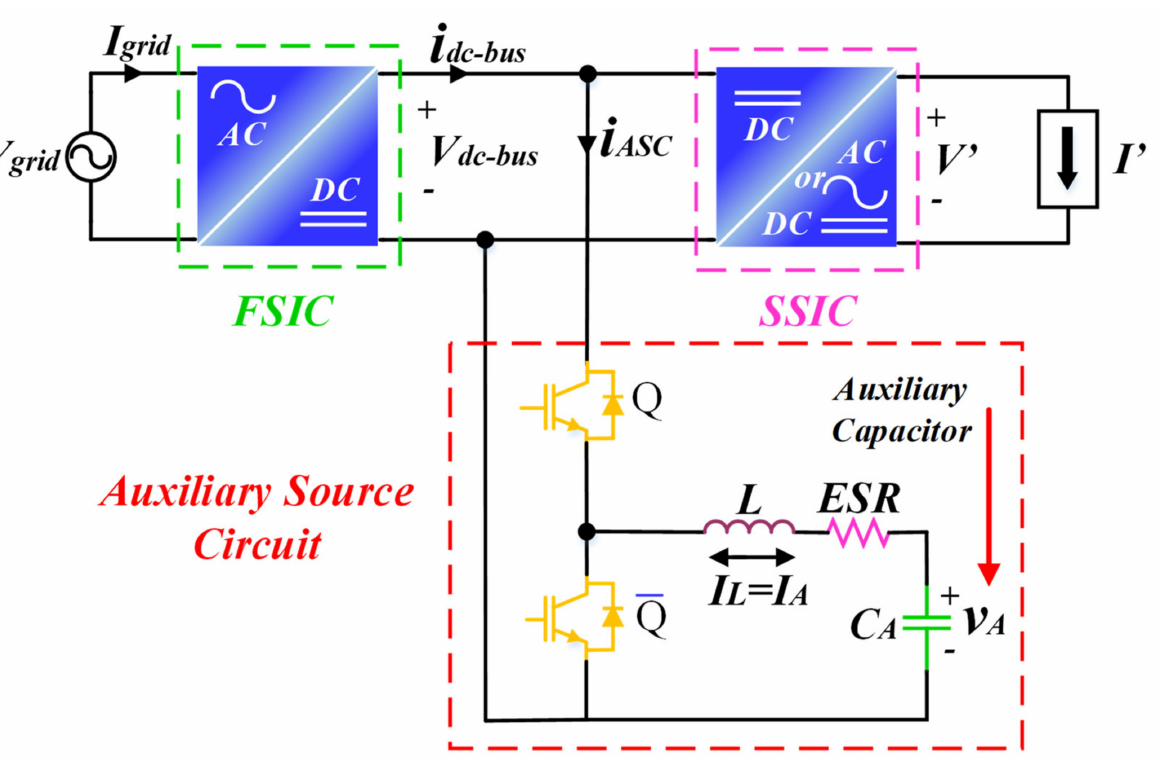
Figure 14. Capacitor-supported power conversion system with additional ASC, shunt